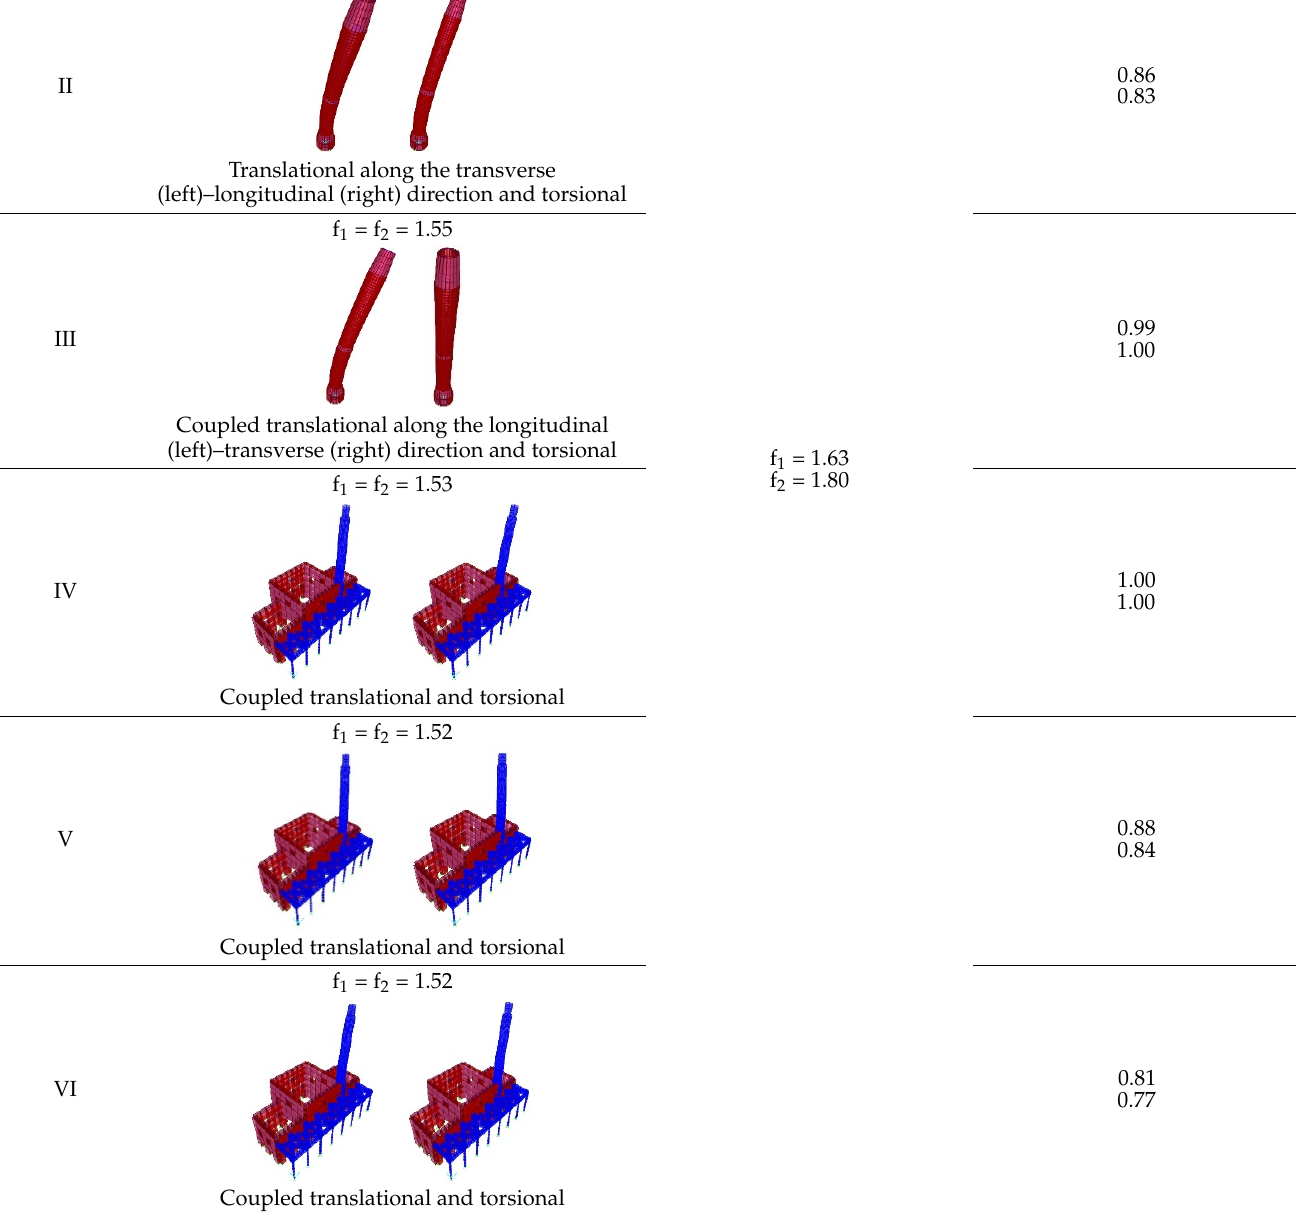
Table 4. Deviation of the eigenfrequencies between the experimental models and FEMs.